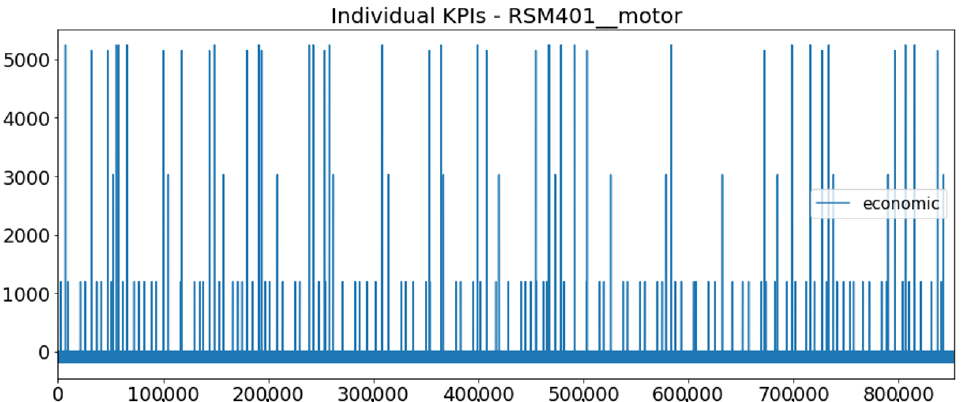
Figure 9. KPI time series for the motor yielded from running the model for the friction welding machine (HWH). The simulation interval has the same length as for training (292 years).